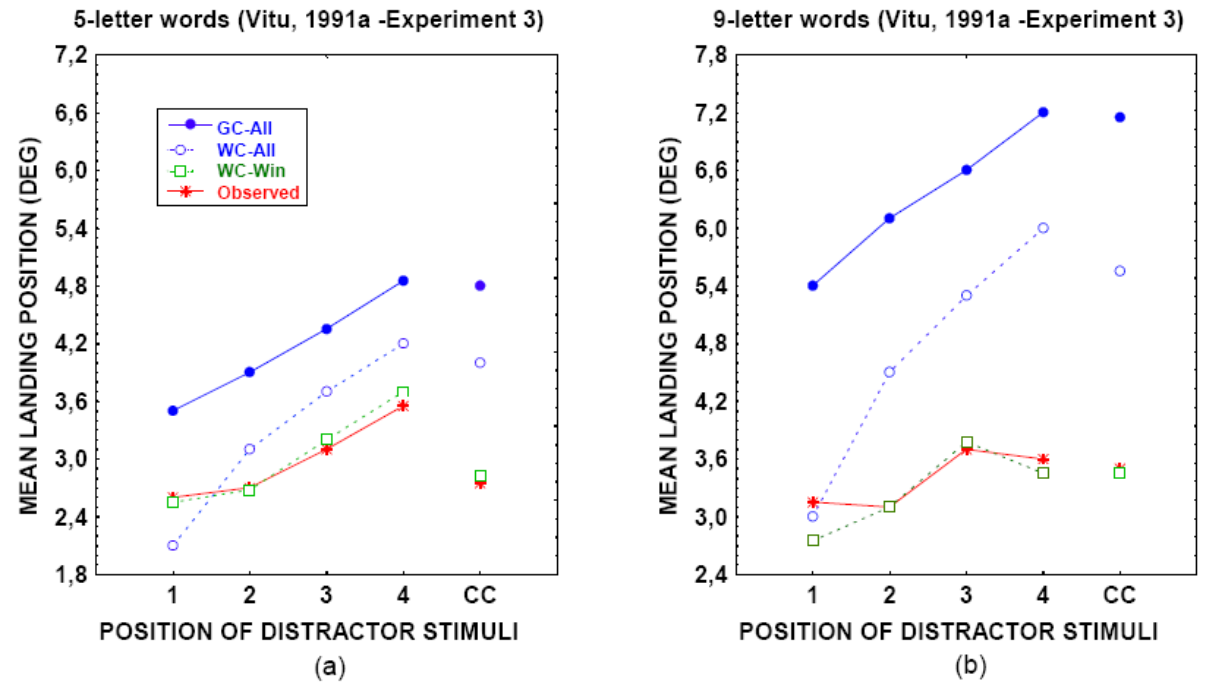
Figure 6. Re-plotted from Vitu’s (1991) Experiment 3. Observed and predicted mean initial landing positions in the first word (in degrees) as a function of the position of the distractor pattern (1-4) and in the control condition (CC) for 5- and 9-letter words (a-b respectively). Predictions were derived from alternative versions of the centre-of-gravity assumption: the geometrical and the cortically-weighted centre of gravity of the full configuration (including all stimuli to the right of the fixation point; GC-all and WC- all respectively), and the cortically-weighted centre of gravity of a 7-letter (or 4.2°) peripheral window from the beginning of the first word (or 1.2° from the fixation point; WC-win respectively). The angular position of the cortically-weighted centre of gravity (CW) was calculated using the following formula, ∑ [ Ф i / (1 + 1.7 Ф i)] = n * CW / (1 + 1.7 * CW), where Ф i is the eccentricity of each visual element (letter or random dot pattern) in the configuration, and n the total number of elements in the configuration.